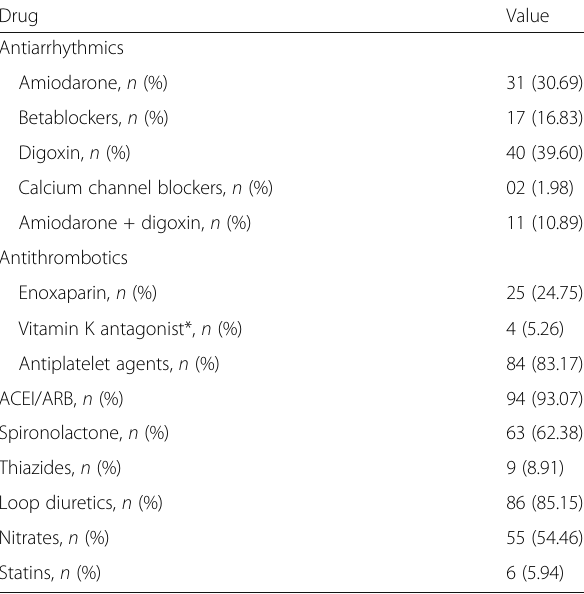
Table 3 Distribution of study patients according to drug treatment